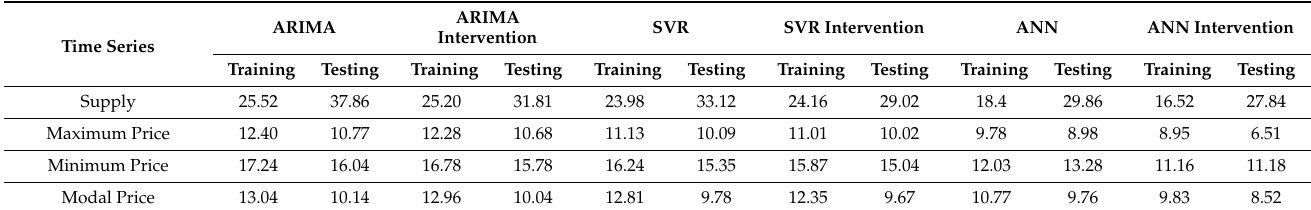
Table 7. Comparison of model performance in terms of MAPE in training sets.